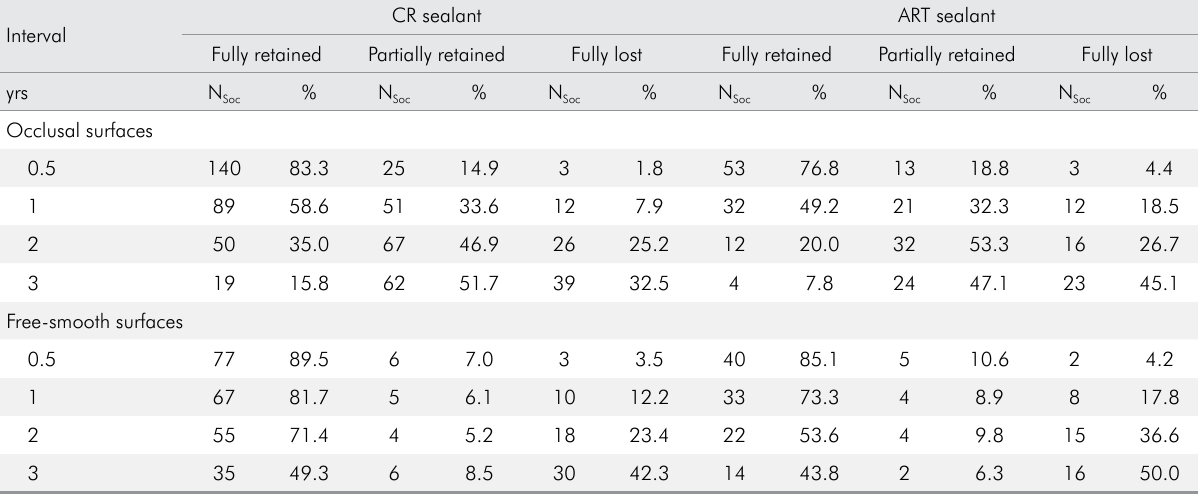
Table 2. Frequency distributions of fully and partially retained and fully lost sealants for occlusal and free-smooth surfaces according to treatment group and interval.